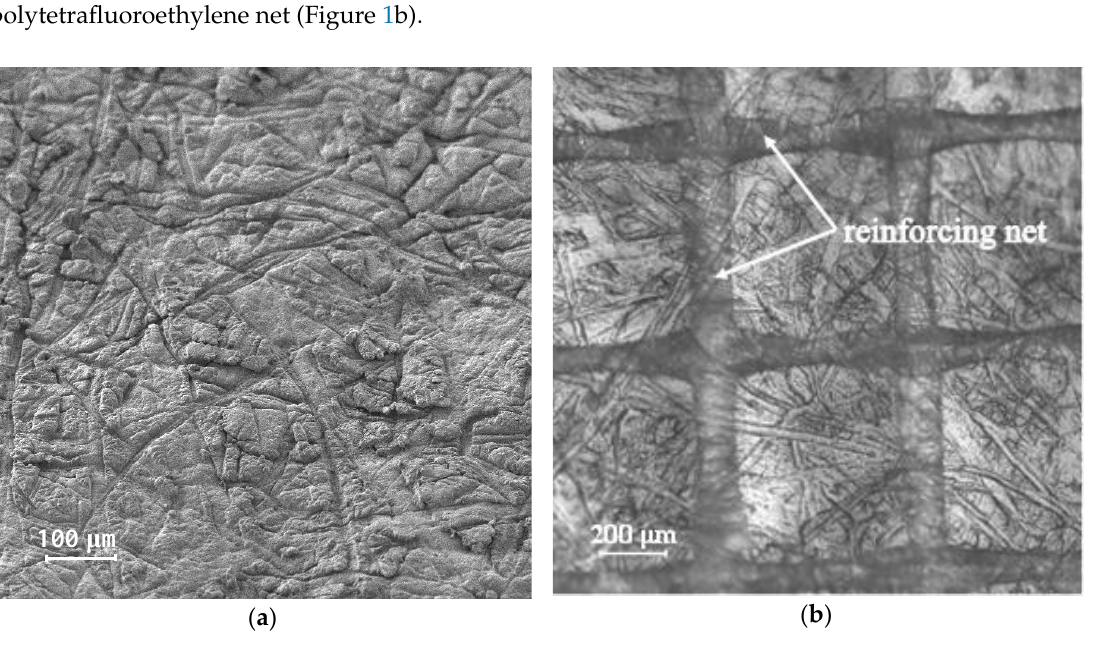
Figure 1. SEM image of the surface of a homogeneous Nafion 438 membrane ( a ) and its micrograph obtained using an optical microscope ( b ).